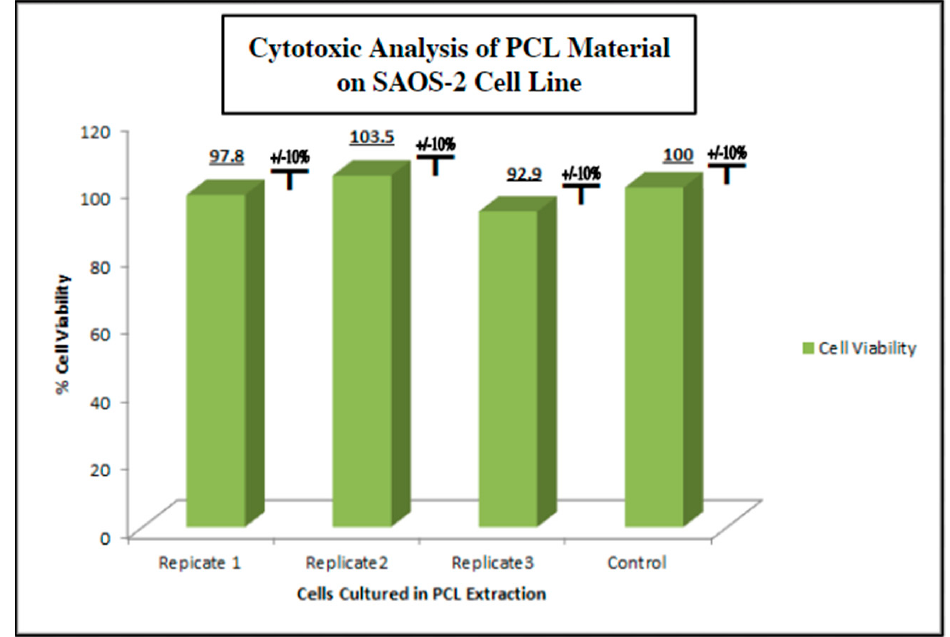
Figure 4. Cytotoxic/cytostatic screening of PCL material extract with SAOS-2 representative osteogenic cell line. SAOS-2 cells were cultured in PCL media extract and assessed for viability via MTT assay n = 8 (Methods, Section 4.4). No cytotoxic or cytostatic activity was noted when compared to the non-extract control group.